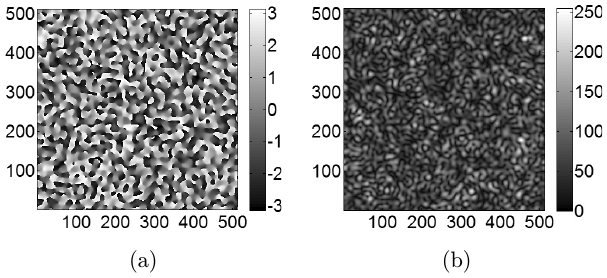
Fig. 5. The complex amplitude pro¯le of a simulated fully- scattered speckle ¯eld at P 2 0 plane in Fig. 3. (a) The phase pro¯le at P 2 0 plane. (b) The amplitude pro¯le at P 2 0 plane. The units of the gray bars are radians in (a), and the normalized standard grayscale in (b),